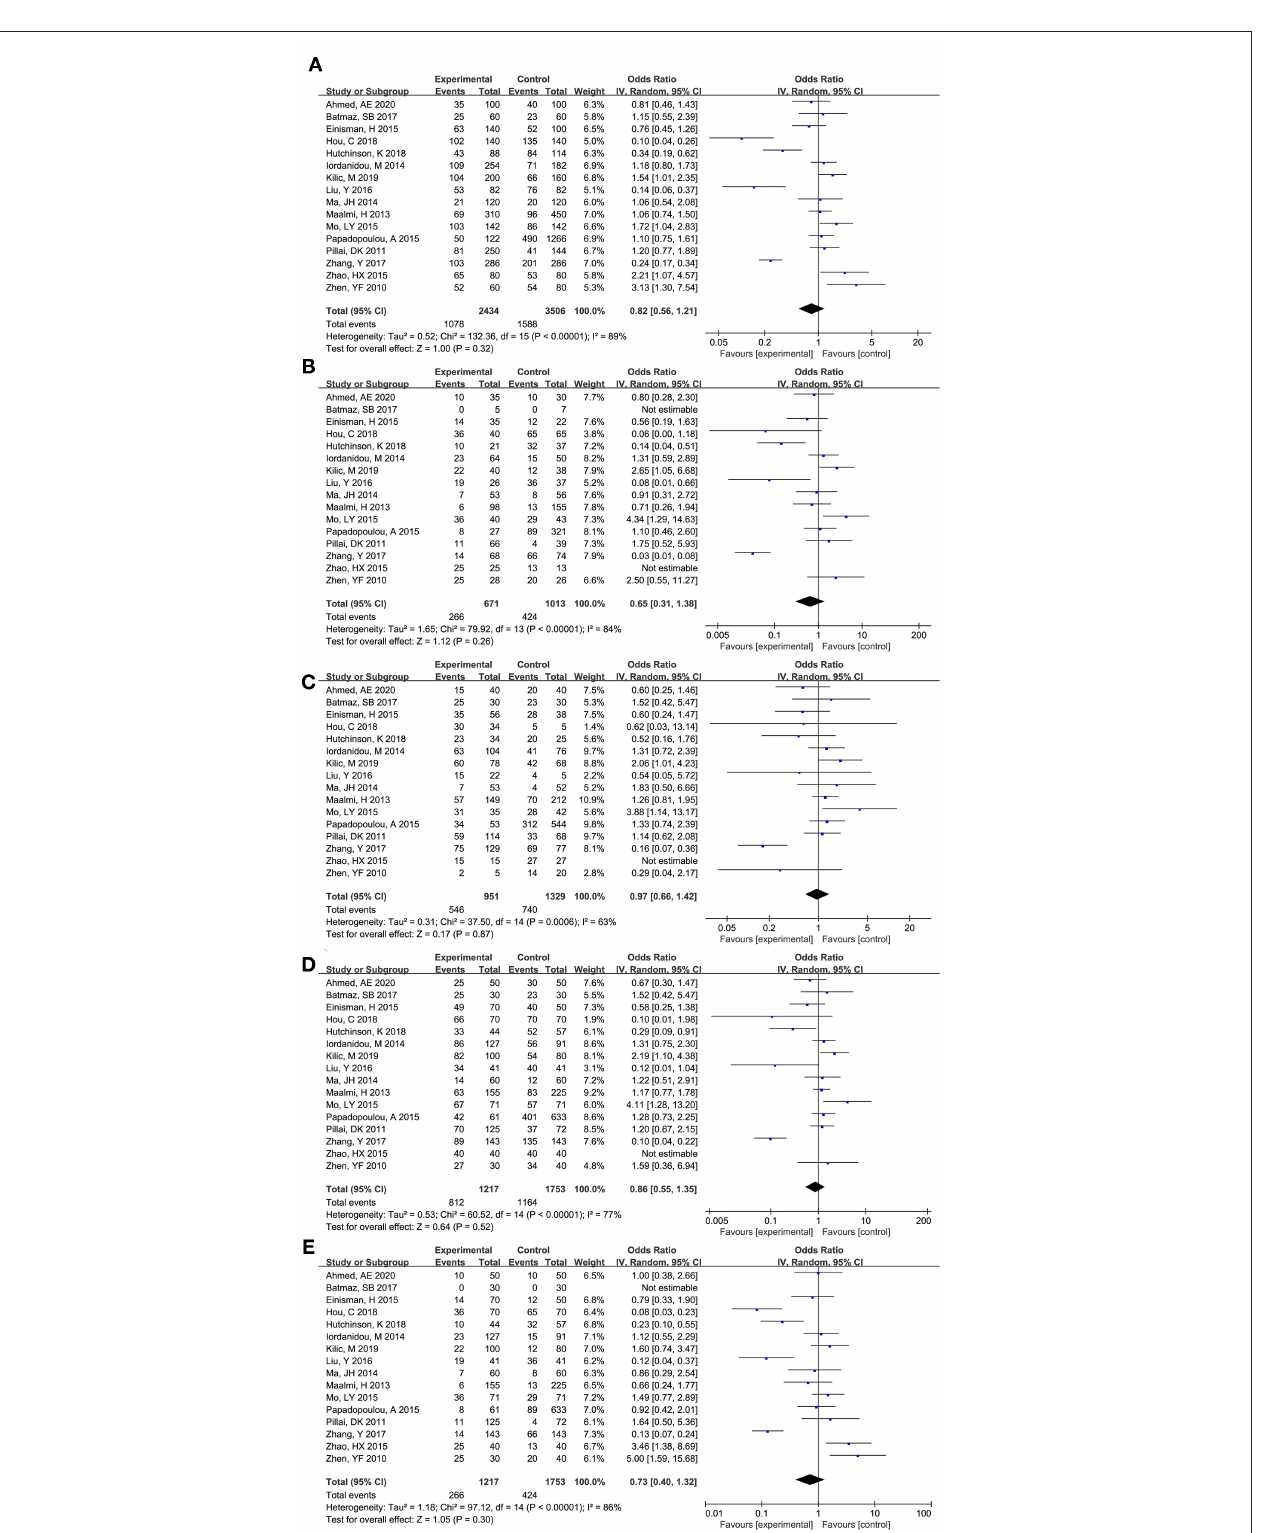
Frontiers in Pediatrics |